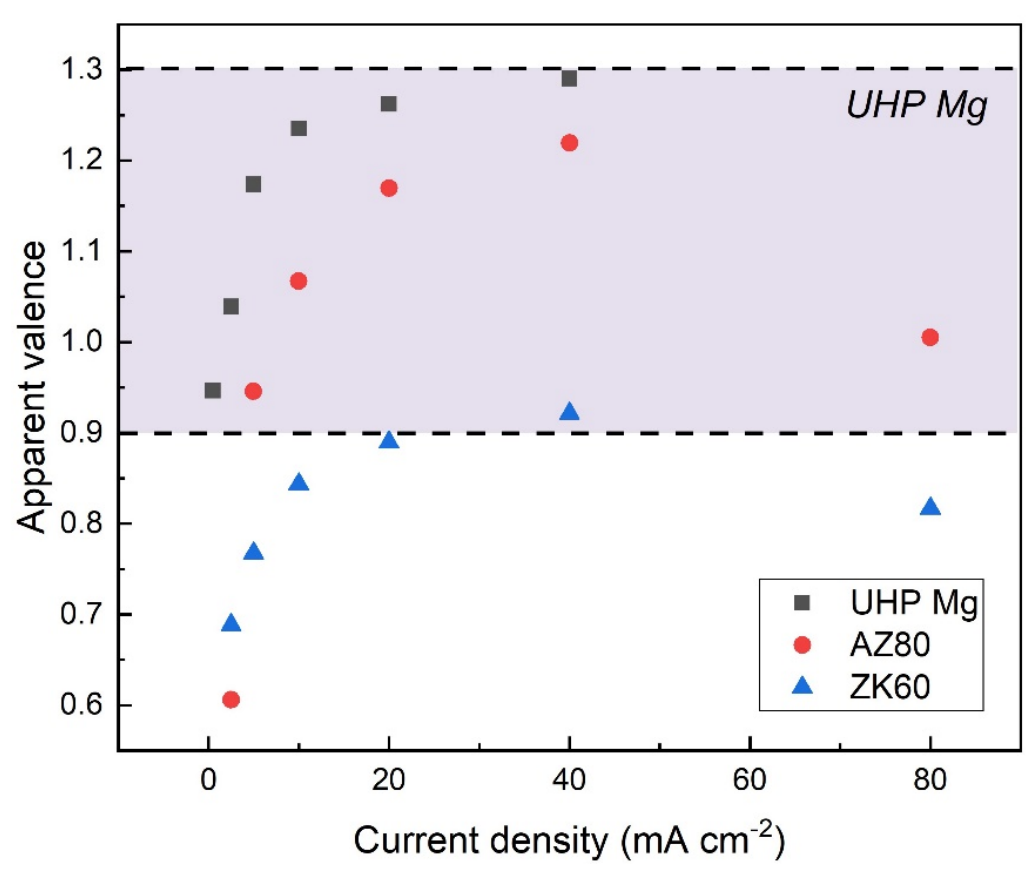
Figure 21. The apparent Mg valence V e,ibattery , for UHP Mg, AZ80 and ZK60 at different current densities during battery testing [101]. The increase in apparent Mg valence with increasing current density is attributed to the decreasing importance of the cathodic partial current at the Mg anode.